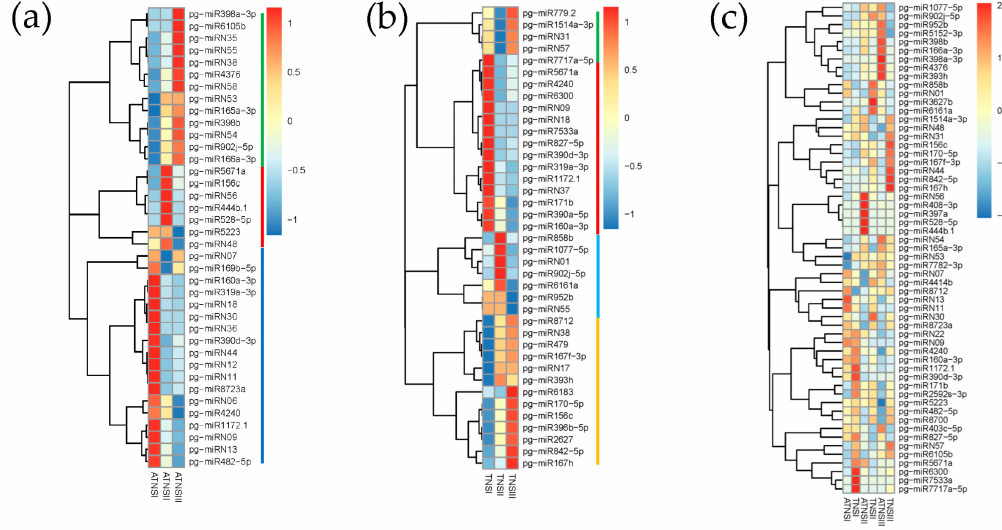
Figure 2. Sequencing frequency profiles of the known miRNAs and novel miRNAs: ( a ) Di ff erent expressed miRNAs among di ff erent stages of FMFs, the green line represents a group of miRNAs highly expressed in ATNSIII, the red line represents a group of miRNAs highly expressed in ATNSII, and the blue line represents a group of miRNAs highly expressed in ATNSI; ( b ) di ff erent expressed miRNAs among di ff erent stages of BFs, the green and yellow lines represent a group of miRNAs highly expressed in TNSIII, the red line represents a group of miRNAs highly expressed in TNSI, and the blue line represents a group of miRNAs highly expressed in TNSII; ( c ) di ff erent expressed miRNAs between FMFs and BFs. ATNSI-ATNSIII, FMFs’ pistils when their bud vertical diameters (BVDs) were 3.0 to 5.0 mm, 5.1 to 13.0 mm, and 13.1 to 25.0 mm, respectively, and TNSI-TNSIII, BFs’ pistils when their BVDs were 3.0 to 5.0 mm, 5.1 to 13.0 mm, and 13.1 to 25.0 mm,